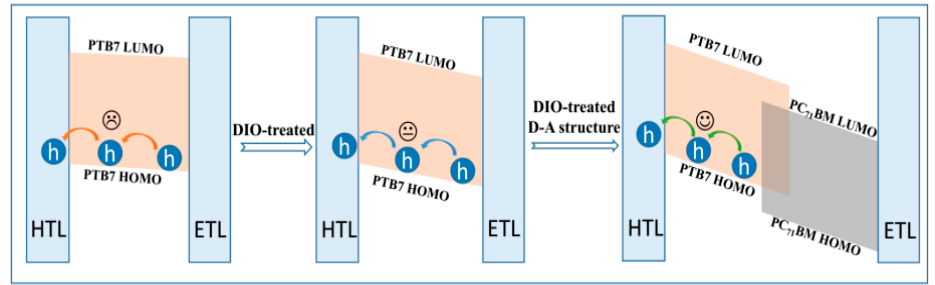
Figure 8. Schematic diagram of hole transport in PTB7, DIO-treated PTB7 and DIO-treated PTB7:PC 71 BM active layers controlled by energy band bending. Hole transport layer and electron transport layer are abbreviated as HTL and ETL, respectively.